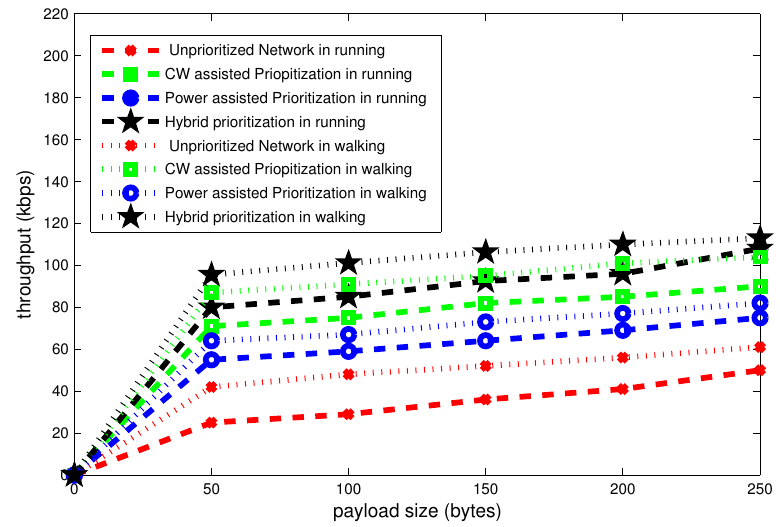
Figure 18. Effect of payload size on throughput in mobile